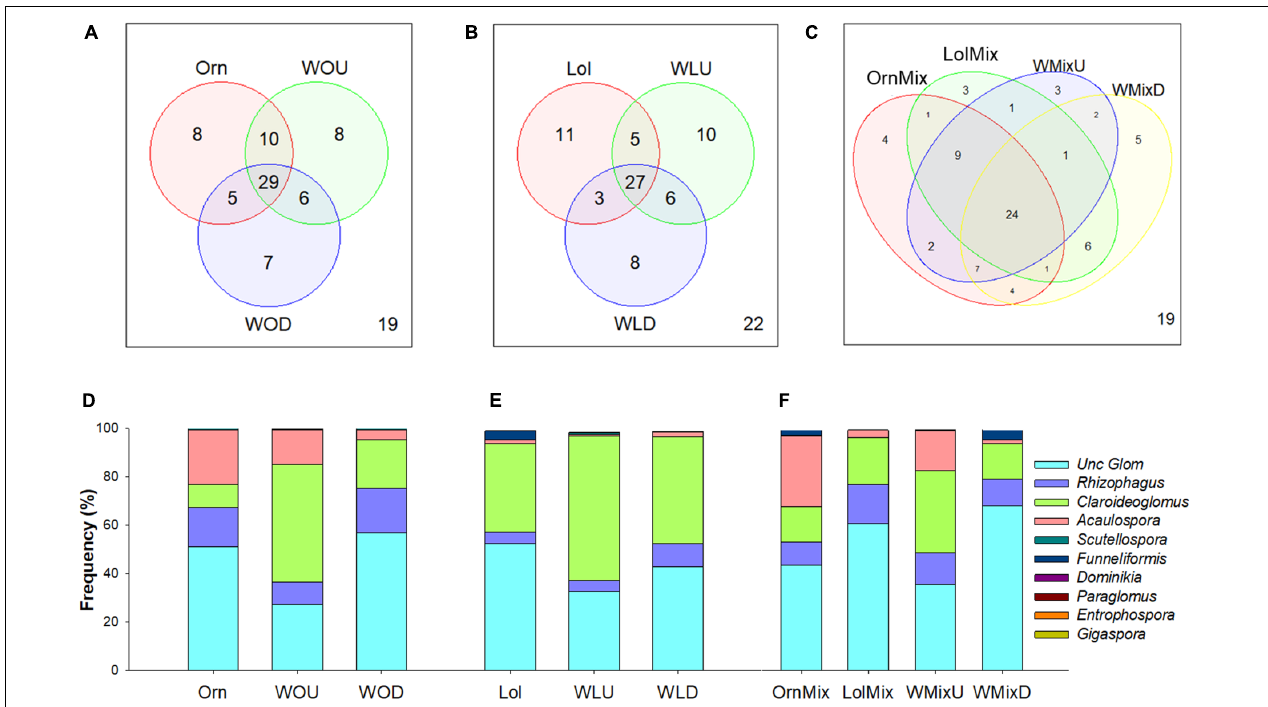
FIGURE 2 | Shared and unique OTUs between Ornithopus compressus , Lolium rigidum and wheat ( Triticum aestivum ), and root AMF communities’ structure. (A–C) Venn diagrams from the three treatments, representing the number of unique and shared OTUs between the different hosts. (D–F) Frequencies of AMF taxa grouped by genera in the different hosts and treatments. OTUs with no match in the databases at genus level were considered as uncultured Glomeraceae. In all cases: Orn ( O. compressus ), Lol ( L. rigidum ), OrnMix ( O. compressus from the mixture with L. rigidum ), LolMix ( L. rigidum from the mixture with O. compressus ). Wheat: WOU (wheat after O. compressus , undisturbed), WOD (wheat after O. compressus , disturbed), WLU (wheat after L. rigidum , undisturbed), WLD (wheat after L. rigidum , disturbed), WMixU (wheat after O. compressus and L. rigidum grown in a mixture, undisturbed), WMixD (wheat after O. compressus and L. rigidum grown in a mixture,